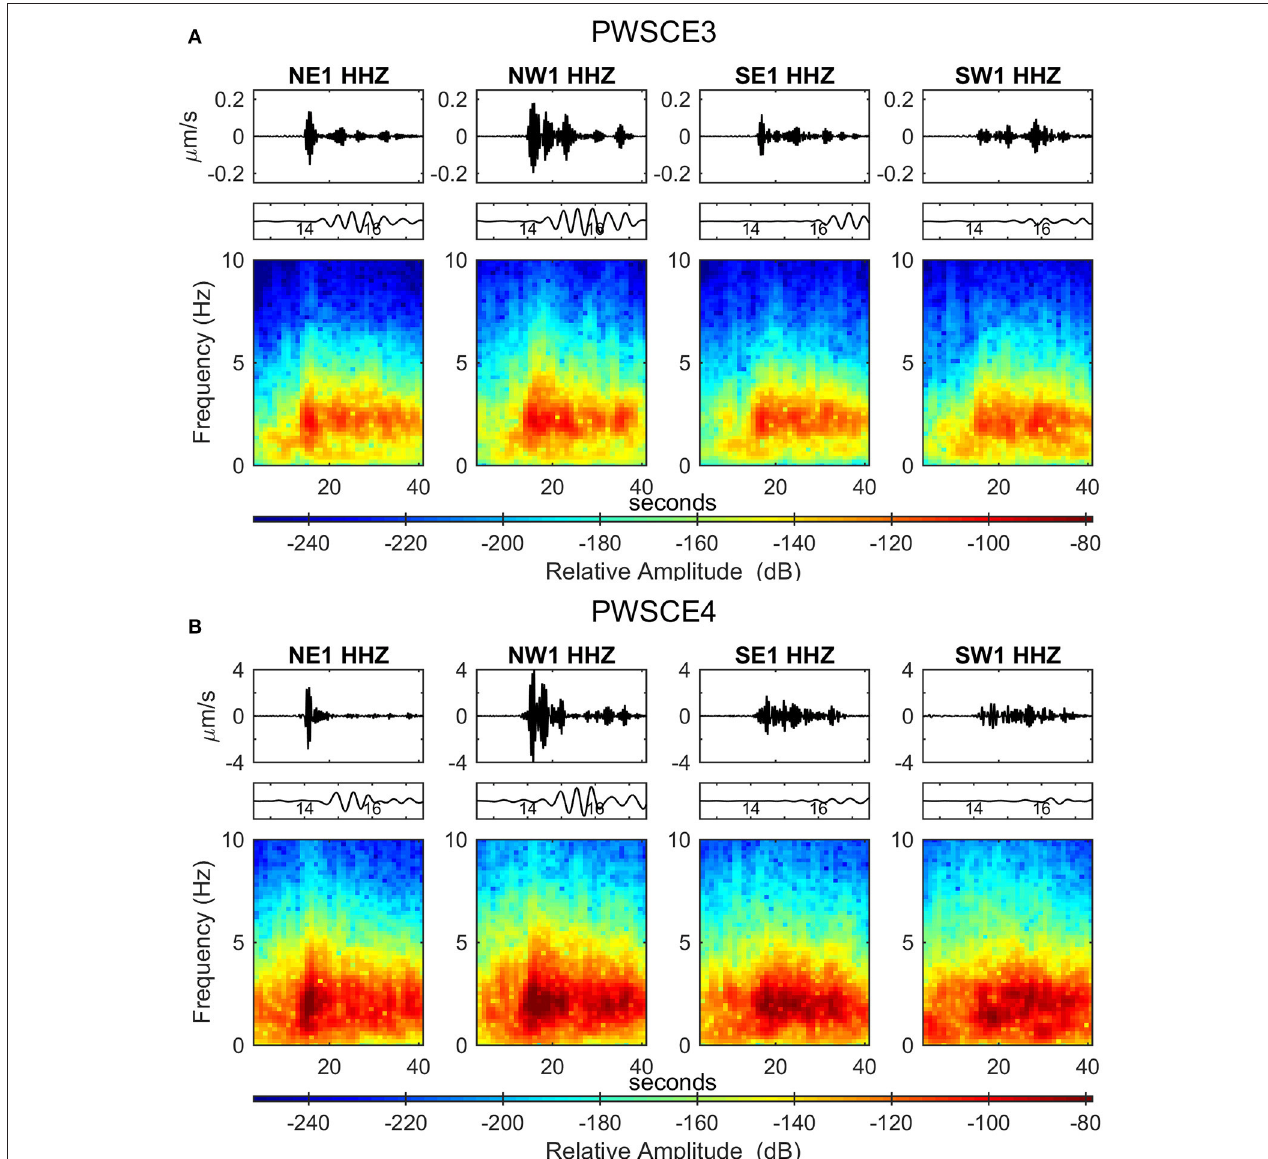
FIGURE 10 | (A) Top Row—PWSCE3 traces. Middle Row—Zoom-in of stacked signal onset. Bottom row—Spectrogram (512 sample window with 80% overlap) of PWSCE3. (B) Top Row—PWSCE4 traces. Middle Row—Zoom-in of stacked signal onset. Bottom row—Spectrogram (512 sample window with 80% overlap) of